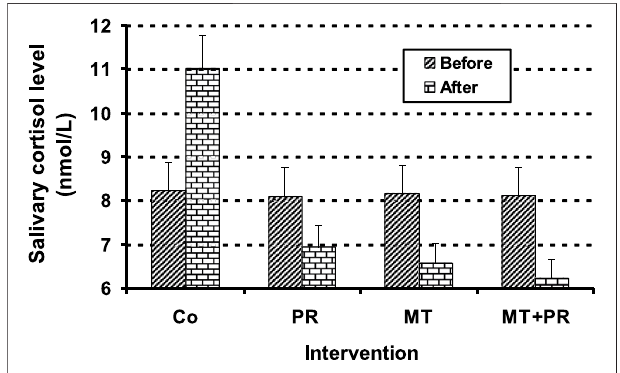
FIGURE2| EvolutionofsalivaryClevelsofTunisianelderlymalepatients withmildADinCo,PR,MTandMT+PRgroupsafter4monthsofintervention at the rate of three sessions of 60-min per week. The results correspond to mean±standarddeviationfor6-7patients.Intervention:Co(control),PR (physic rehabilitation), MT (music therapy) and MT + PR (music therapy + physic rehabilitation).